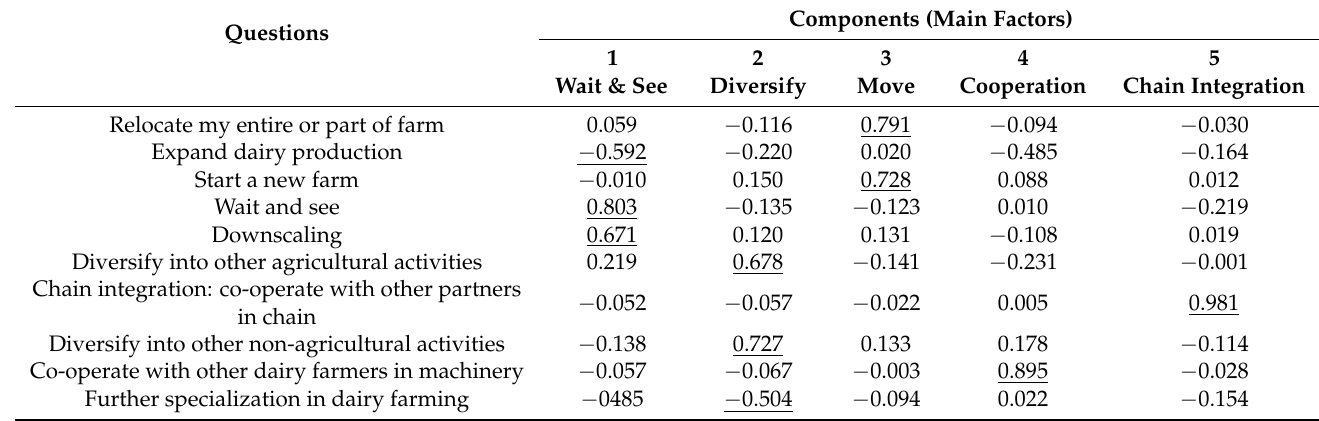
Table 2. Correlations between development paths (i.e., components) and original questions about strategic direction ( n = 798); highest correlations within components are